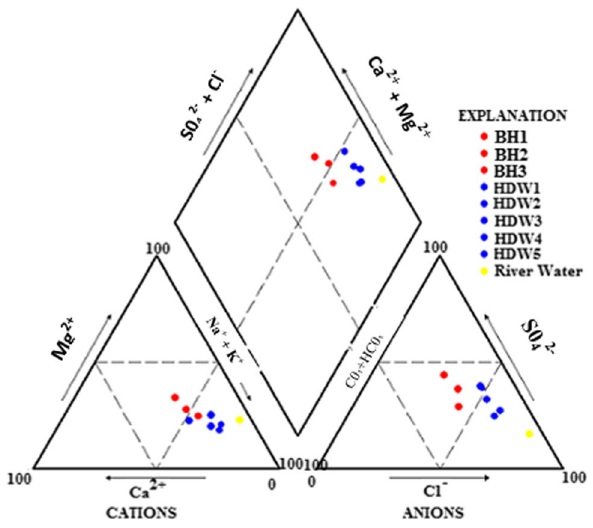
Fig. 10 Piper diagram of the groundwater samples and River Escra- vos